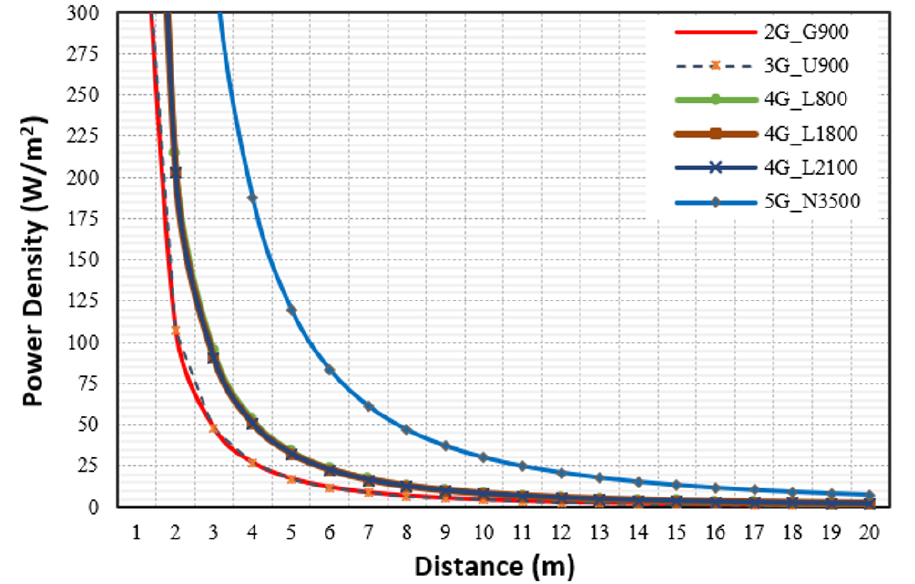
Figure 6. The power densities (W/m 2 ) in the main direction for the macro site shared by 4 MNOs. With reference to the ICNIP for the GP, Figure 7 displays the exposure ratio for each technology calculated by Equation (4) in the horizontal direction and TER for the macro site shared by a single MNO, two MNOs, three MNOs, and four MNOs.